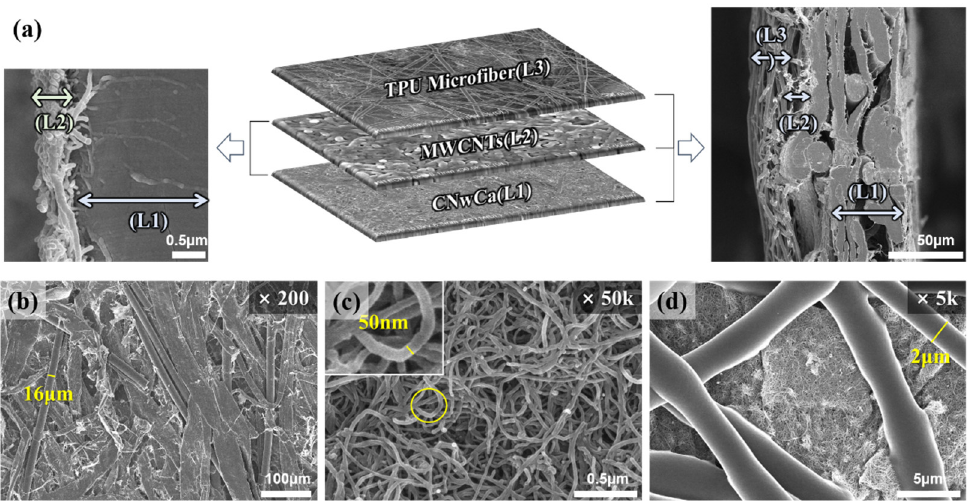
Figure 3. ( a ) Scanning electron microscope (SEM) images and configuration of the MWCNT composite conductive nonwoven. SEM images of ( b ) CNwCa, ( c ) MWCNTs on CNwCa, and ( d ) TPU microfibers on MWCNTs + CNwCa.